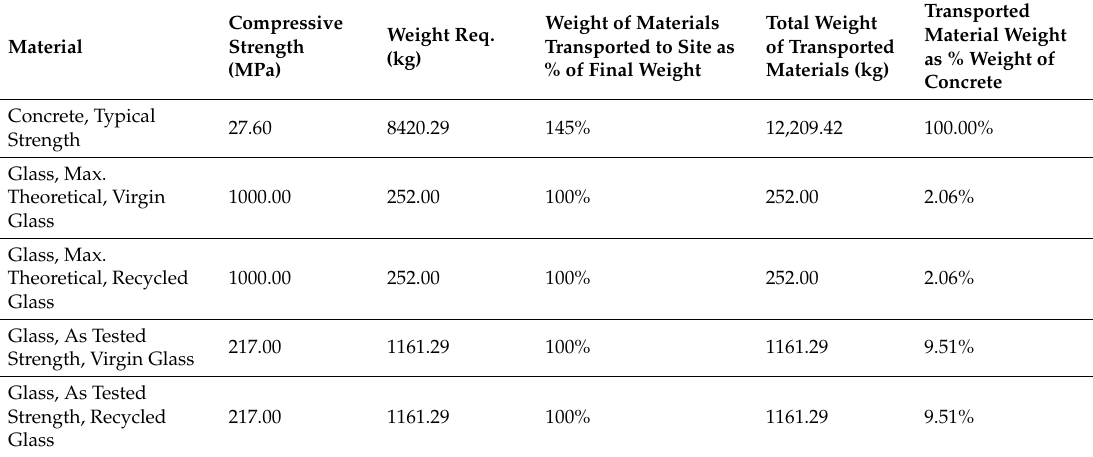
Table 2. The required weight from Table 1, for the compression only materials, is used to compare the transportation and mining requirements for each material. This is done to show that glass, having a higher strength to mass, greatly outperforms concrete. This would help to reduce the amount of greenhouse gas emissions developed during the transportation of